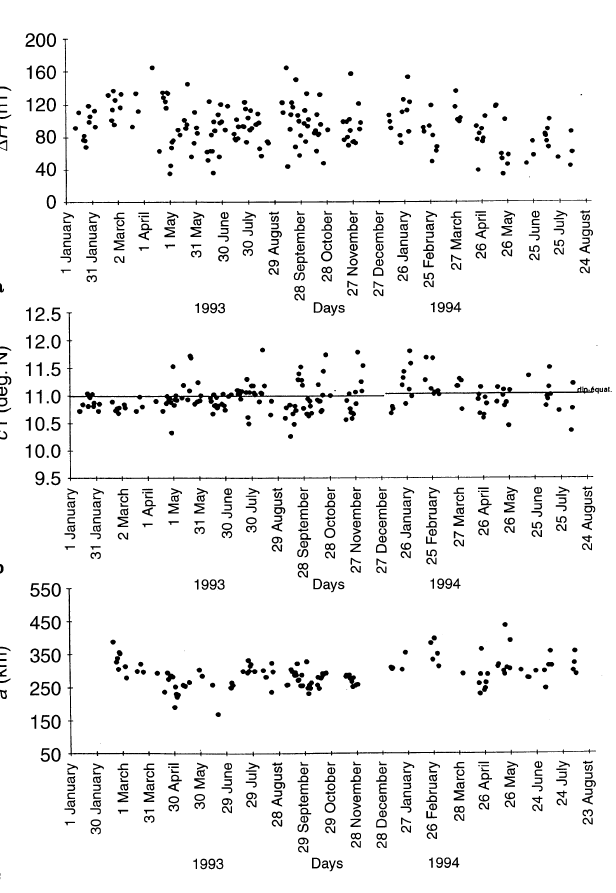
Fig. 14a–c. Day-to-day variability of the EEJ parameters: a ampli- tude of the horizontal component (cid:68) H , b the latitude of the center c , and c the half-width a Fig. 15a–c. Seasonal variations of the EEJ parameters: a amplitude